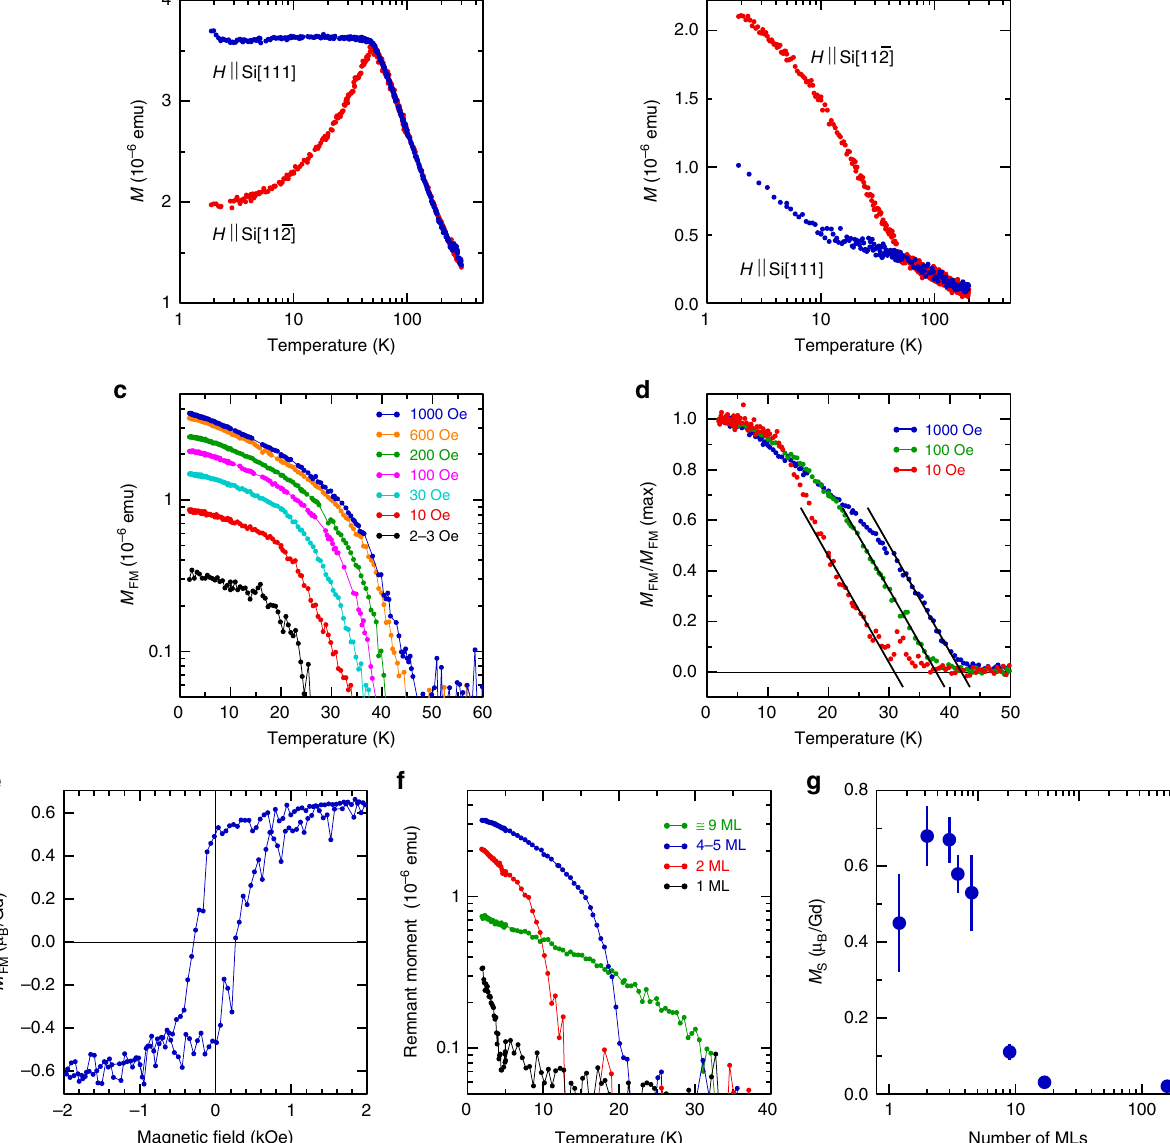
Fig. 3 Magnetism of GdSi 2 materials. a Temperature dependence of the AFM magnetic moment in bulk GdSi 2 ( ≅ 160 ML) measured in a magnetic fi eld 1 (cid:1) (cid:3) kOe along directions Si[111] (blue) and Si 112 (red). b Temperature dependence of the magnetic moment in 17 ML GdSi 2 measured in a magnetic fi eld 1 (cid:1) (cid:3) kOe along directions Si[111] (blue) and Si 112 (red). c Temperature dependence of the FM moment in the 4-5 ML sample of GdSi 2 in magnetic fi elds 2-3 Oe (black), 10 Oe (red), 30 Oe (turquoise), 100 Oe (purple), 200 Oe (green), 600 Oe (orange), and 1 kOe (blue). d Temperature dependence of the normalized FM moment in the 2 ML sample of GdSi 2 in magnetic fi elds 10 Oe (red), 100 Oe (green), and 1 kOe (blue). e Magnetic fi eld dependence of the FM moment in the 2 ML sample of GdSi 2 at 2 K. f Temperature dependence of the remnant moment (after cooling at 500 Oe) in GdSi 2 samples of different thickness: 1 ML (black), 2 ML (red), 4-5 ML (blue), and ≅ 9 ML (green). g Dependence of the saturation moment at 2 K on the number of GdSi 2 MLs. Error bars are